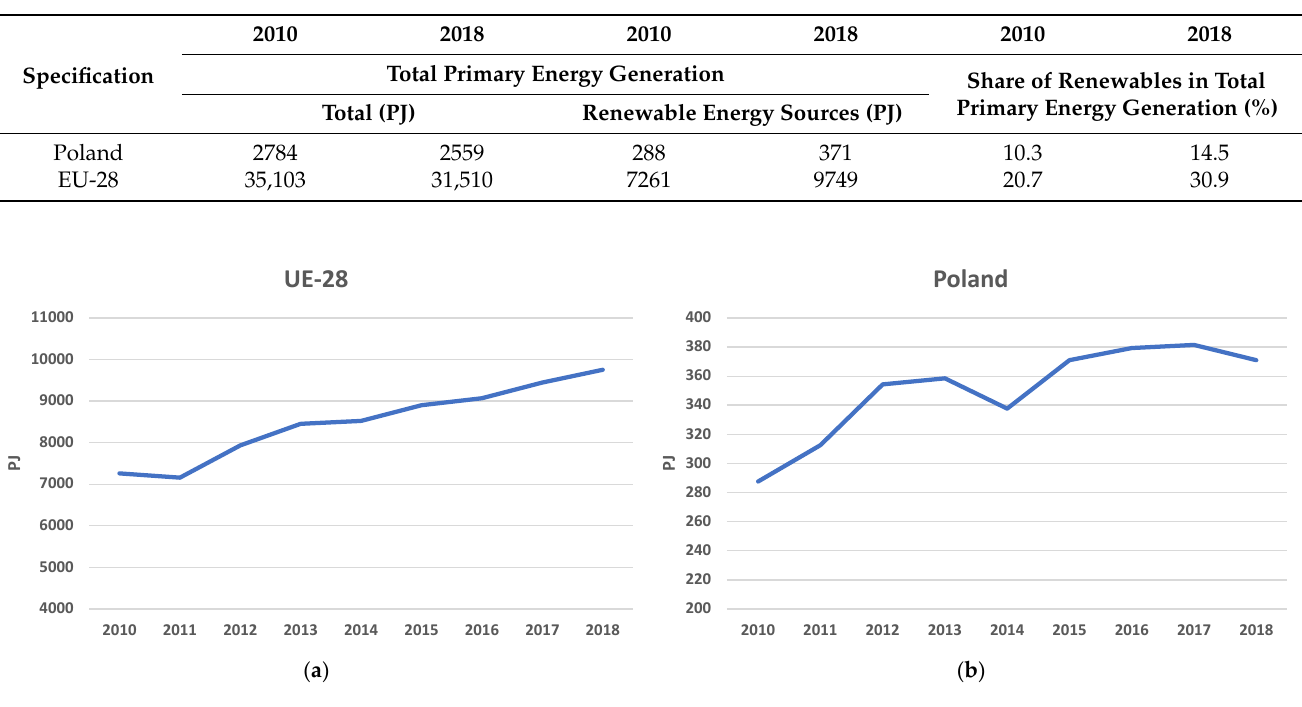
Table 1. Total primary energy generation in EU-28 and in Poland [31].